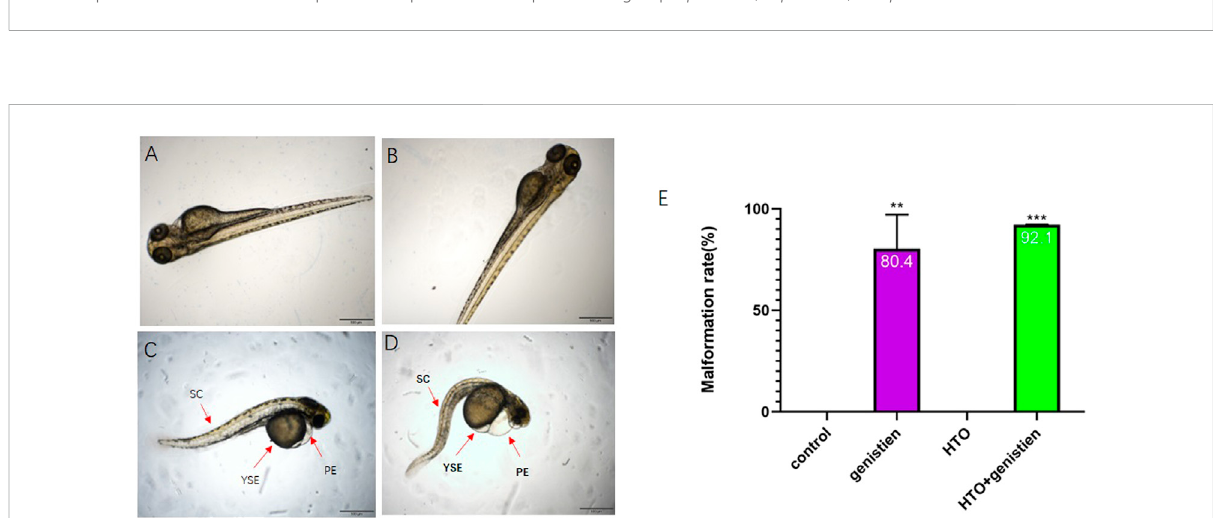
FIGURE 2 The morphology of zebra fi sh larvae. (A) control group; (B) 3.7*10 2 Bq/ml HTO group; (C) 1.4 mg/L genistein group; (D) 3.7*10 2 Bq/ml HTO+1.4 mg/L genistein group; (E) the malformation rate of 96 hpf zebra fi sh larvae. 10 samples were taken from each parallel samples of